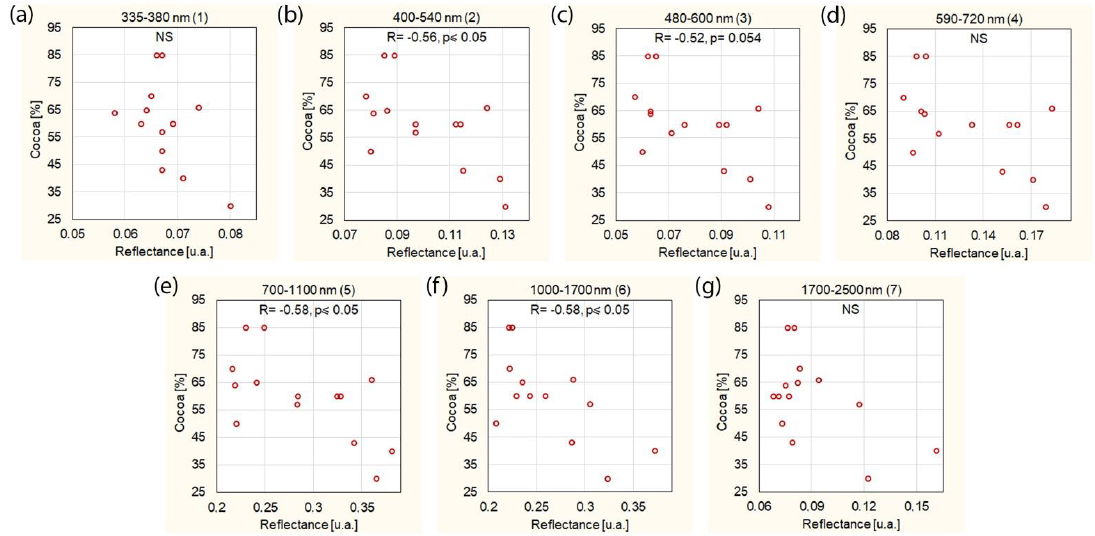
Figure 5. Correlation between cocoa content in chocolate and reflectance for different wavelength ranges: ( a ) 335 – 380 nm, ( b ) 400 – 540 nm, ( c ) 480 – 600 nm, ( d ) 590 – 720 nm, ( e ) 700 – 1000 nm, ( f ) 1000 – length ranges: ( a ) 335–380 nm, ( b ) 400–540 nm, ( c ) 480–600 nm, ( d ) 590–720 nm, ( e ) 700–1000 nm, 1700 nm, ( g ) 1700 – 2500 nm. NS — not significant. ( f ) 1000–1700 nm, ( g ) 1700–2500 nm. NS—not